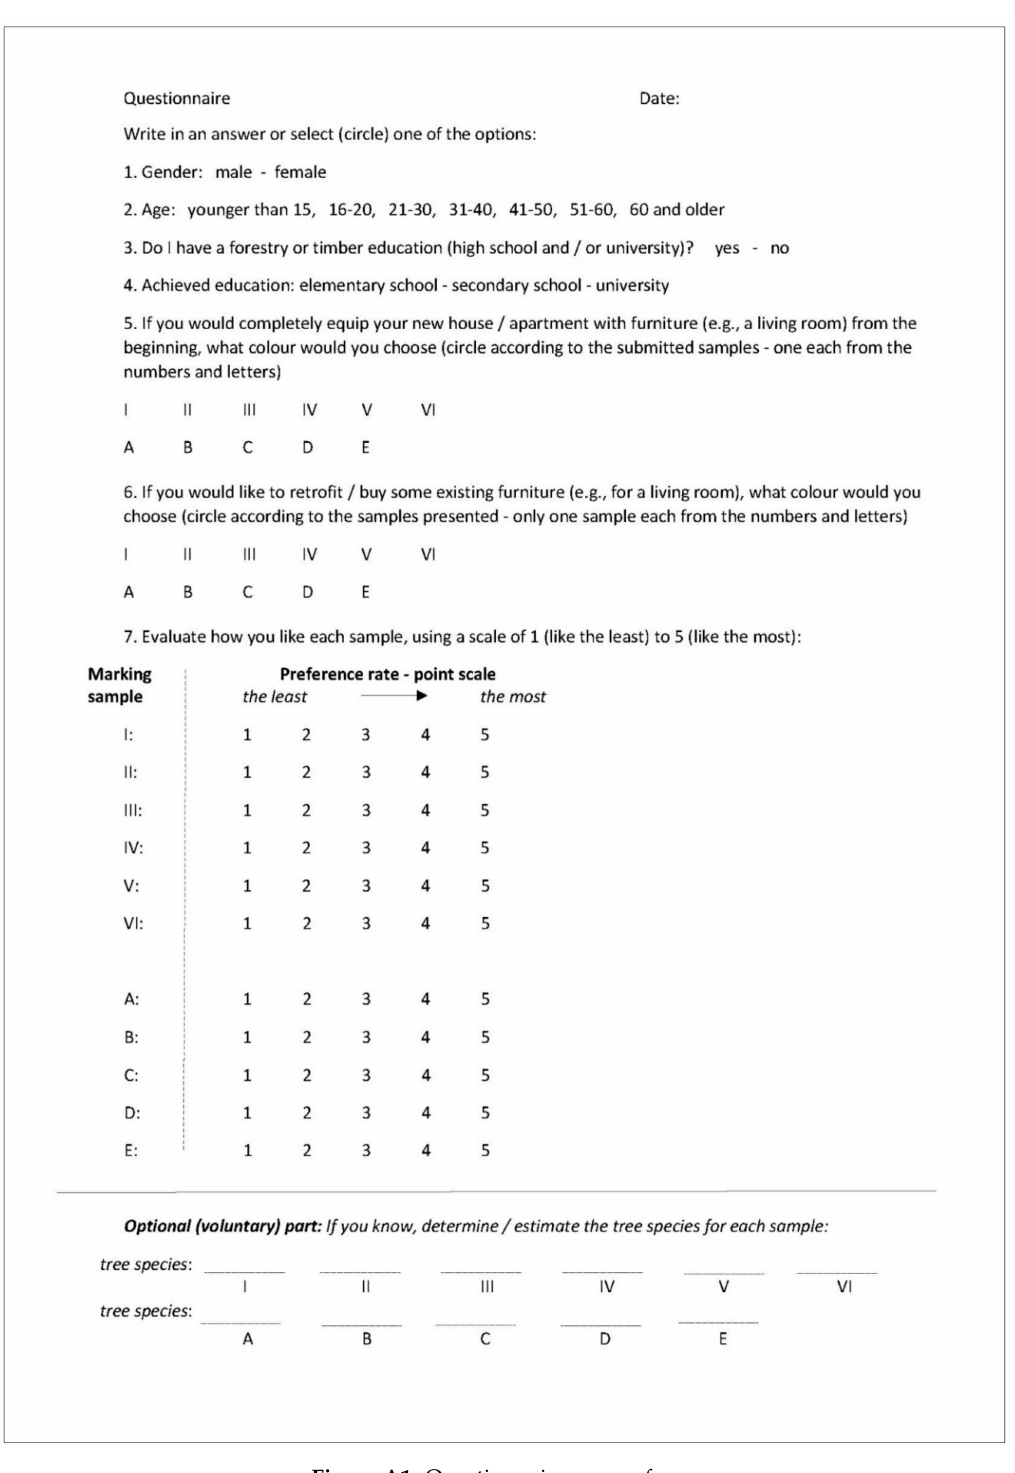
Figure A1. Questionnaire survey